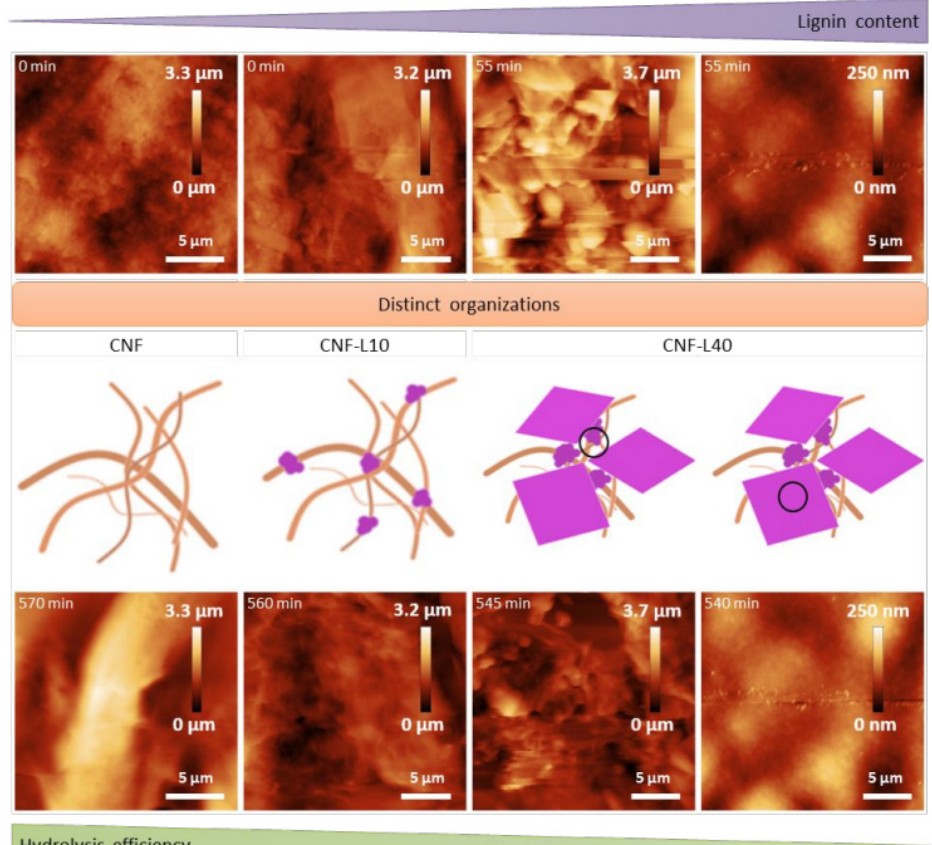
Figure 6. Schematic representation of the main conclusions regarding Cellic CTec 2 efficiency towards substrate with increasing lignin content and distinct structural organization; adapted from [58].